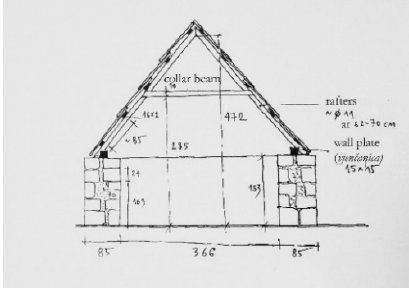
Figure 27. Cross-section through the glada’s construction, sketch: A. Kapetanovi ć .